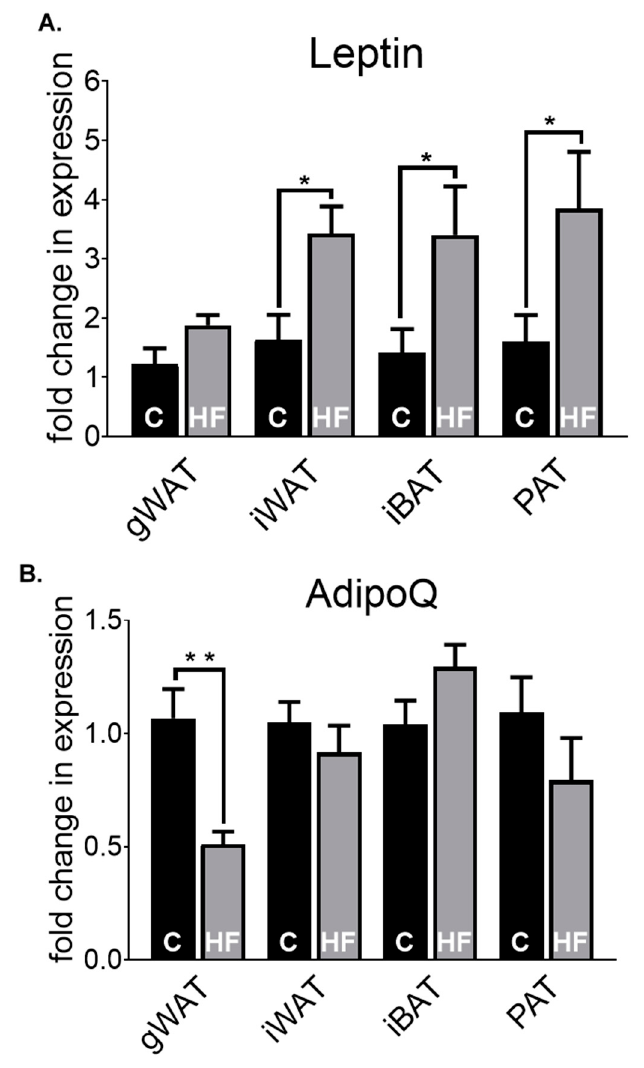
Figure 3. Leptin ( A ) and AdipoQ ( B ) fold change in mRNA expression in gWAT, iWAT, iBAT and PAT of chow (C)- or high-fat (HF)-fed 30-week-old male mice. All data are relative to the housekeeping gene PPIA and normalised to their respective control (C) within each depot. All data represent mean + s.e.m. Data were analysed by an unpaired t -test between C and HF of each depot. N = 6–12. * p < 0.05, ** p < 0.01, *** p < 0.001 and **** p < 0.0001.